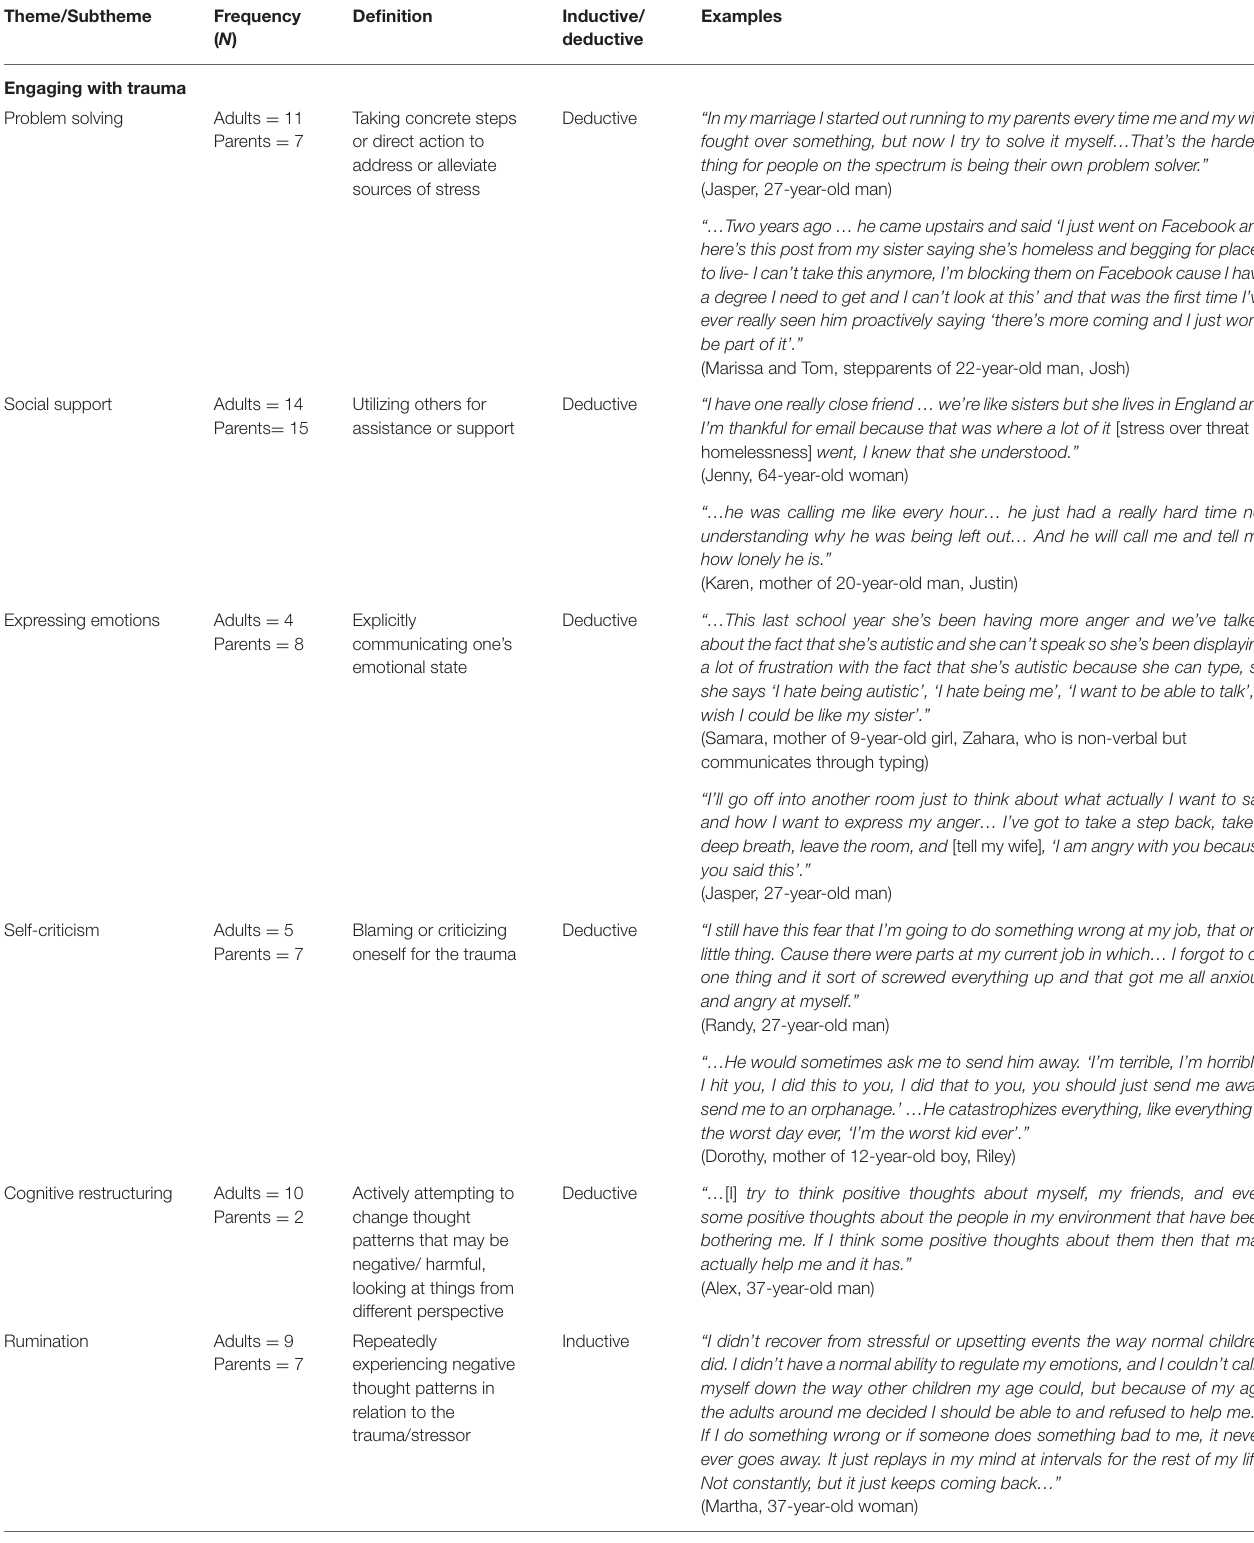
TABLE 3 | Themes and subthemes.